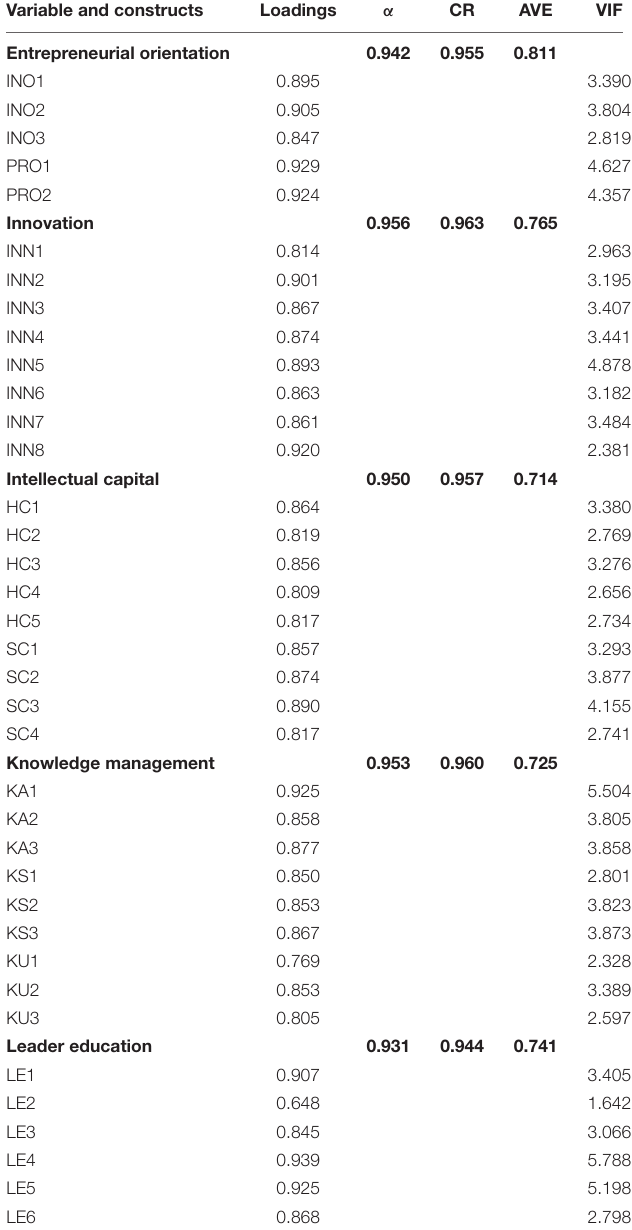
TABLE 2 | Measurement